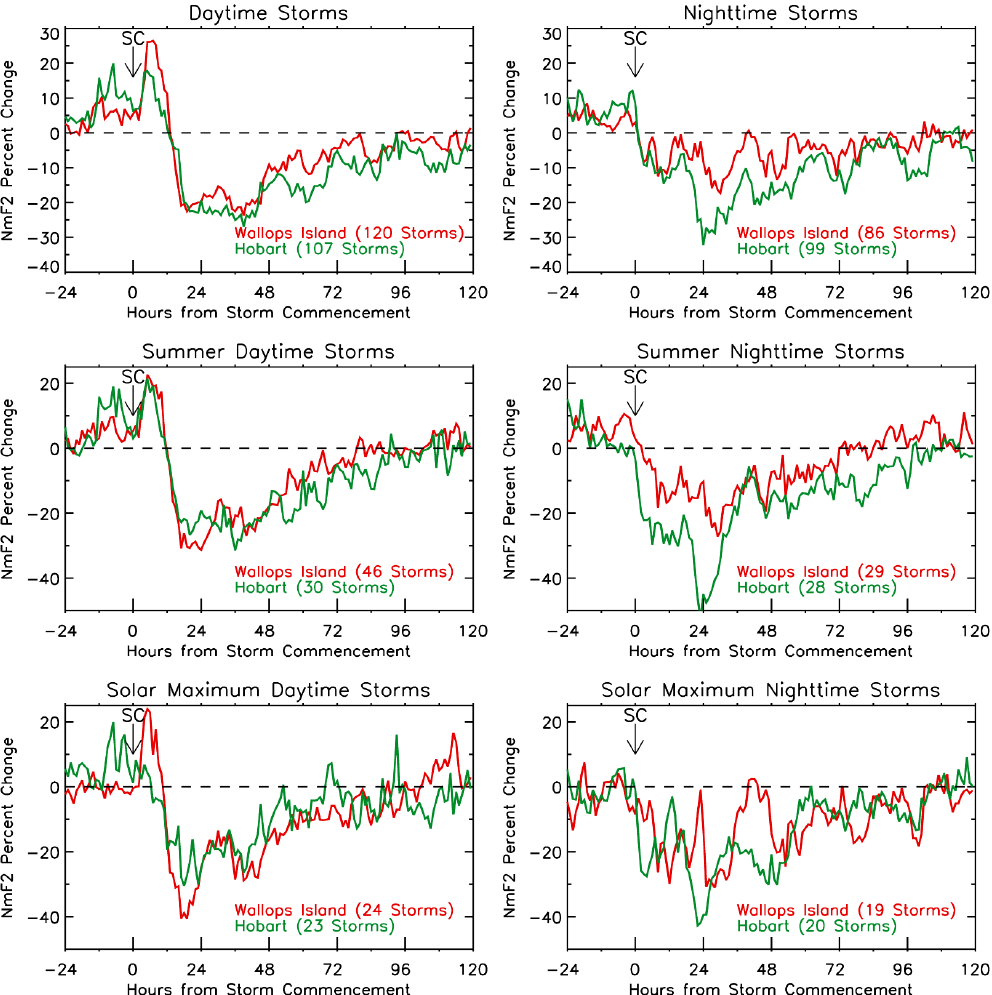
Fig. 8. Comparison of average storm-time patterns at Wallops Island and Hobart for day versus night SC times. Panels (a) and (b) describe the total sample of storms, panels (c) and (d) describe storms during local summer months, and panels (e) and (f) storms during solar maximum